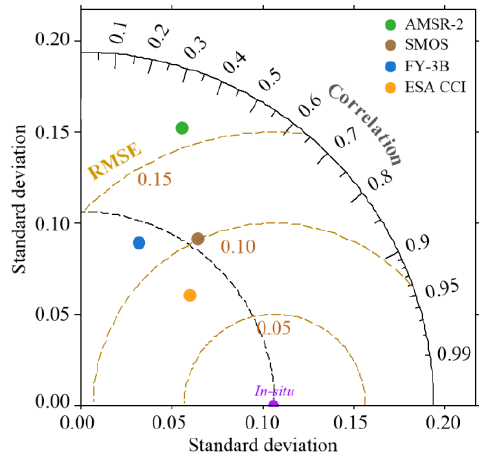
Figure 9. Simple Taylor diagram displaying statistical comparisons between 1 km SSM downscaled predictions combining two cases and ground-based measurements for AMSR-2, SMOS, FY-3B, and ESA CCI. The in situ point is for all the validation